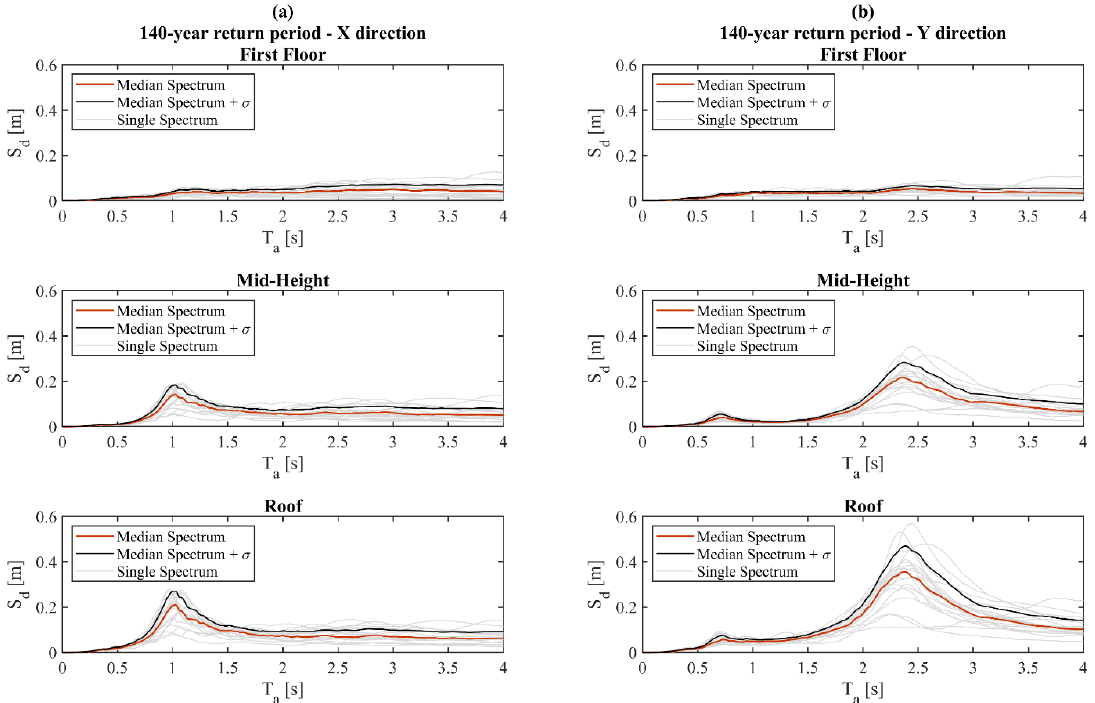
Figure 7. Individual and statistical displacement floor spectra for RP = 140 years—First floor, mid-height and roof: ( a ) longitudinal, X direction; ( b ) transverse, Y direction.